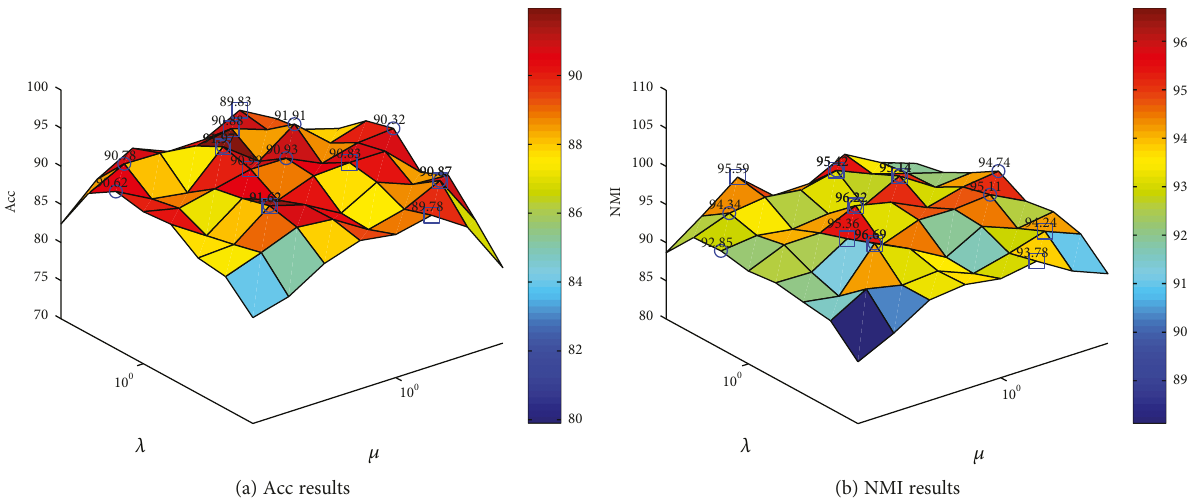
Figure 7: Clustering accuracy of the proposed method with respect to the parameters μ and λ on the extended YaleB